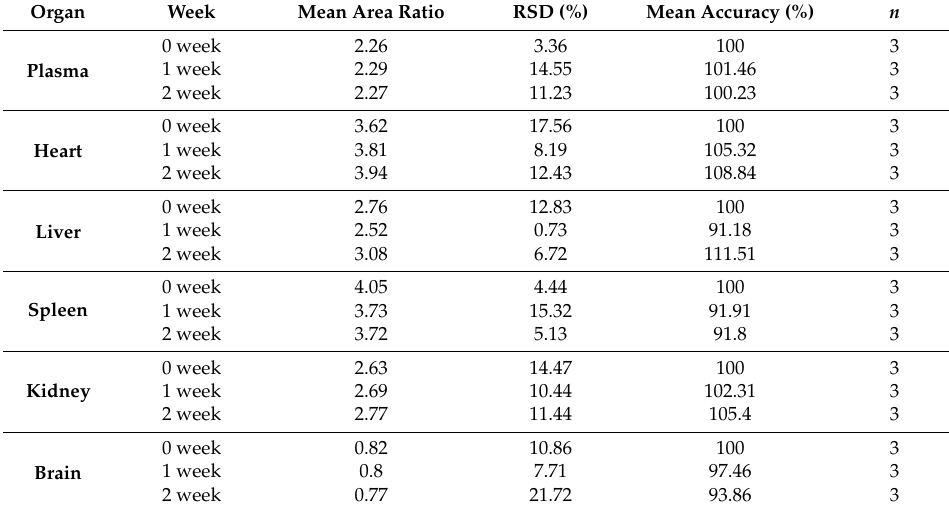
Table 5. Long-term stability results for